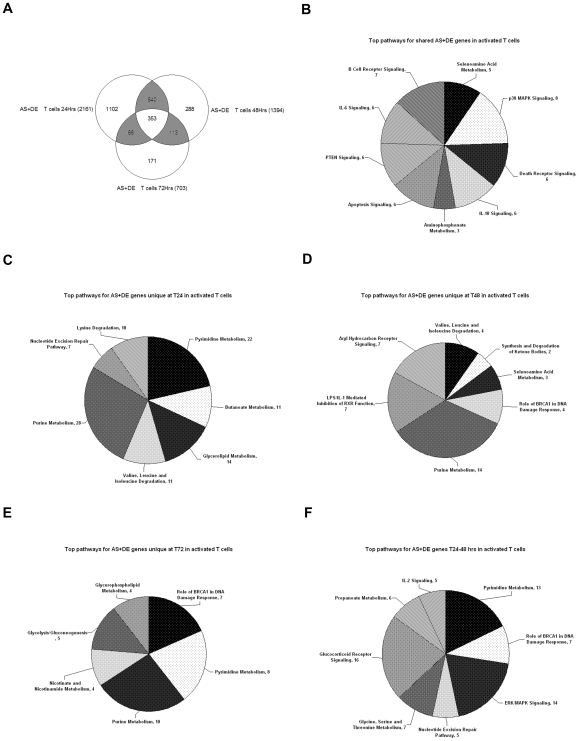
Canonical pathways for alternatively spliced and differentially expressed T cell genes (p<0.001) shows both immune/inflammatory mechanisms and metabolism.(A) Venn diagram representing the alternatively spliced and differentially expressed (AS+DE) genes detected at 24, 48, and 72 hours in activated T cells, with total number of detected genes per time point shown in parenthesis, number of genes unique to each time point shown by the number inside the circle and number of genes shared between time points in the shaded overlapping areas, with number of genes detected at all three time points shown in the central overlap. (B–F) Pie charts representing the Ingenuity Pathway Analysis output for the top canonical pathways populated by AS+DE genes during T cell activation: (B) shared at all time points, (C) genes unique to 24 hour time-point, (D) genes unique to the 48 hour time-point, (E) genes unique to the 72 hour time-point, (F) genes uniquely detected during the transition between 24 and 48 hour time-points. Numbers next to pathway name indicate the number of detected genes that are assigned to each pathway. The size of each shaded slice is proportional to the number of genes per pathway compared to total number of genes per chart.